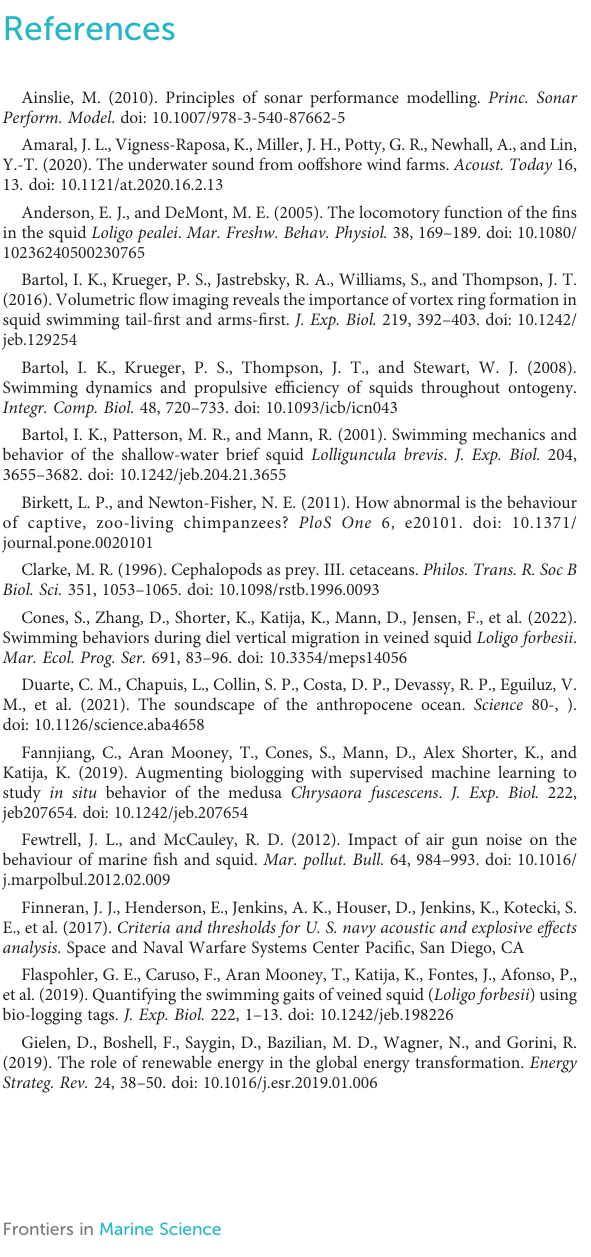
SUPPLEMENTARY FIGURE 1 Magnetic fi eld strength as a method to measure fi n rates. Fin and magnet position were linked, so propagating fi n waves during swimming distorted the magnetic fi eld at a frequency equivalent to the fi n